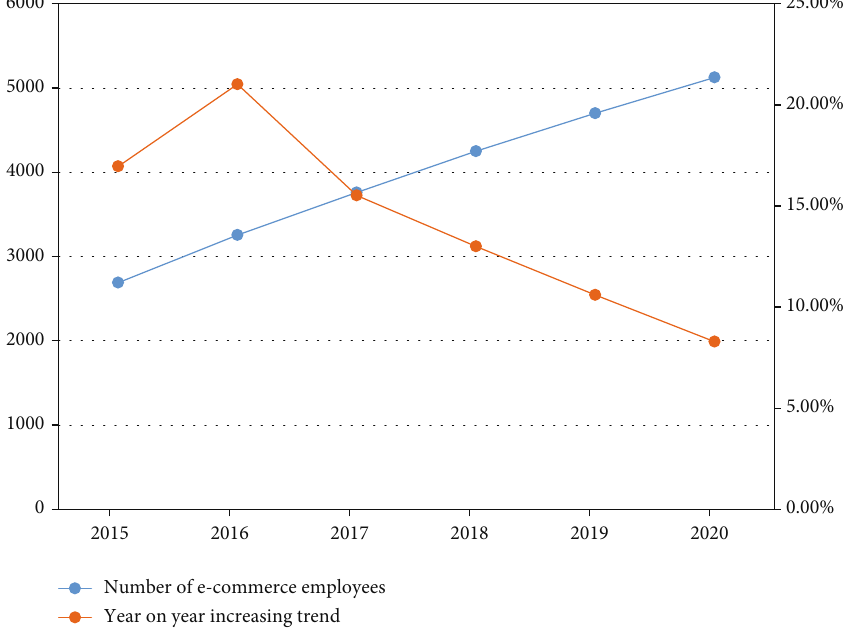
Figure 6: Statistical chart of increasing trend of e-commerce